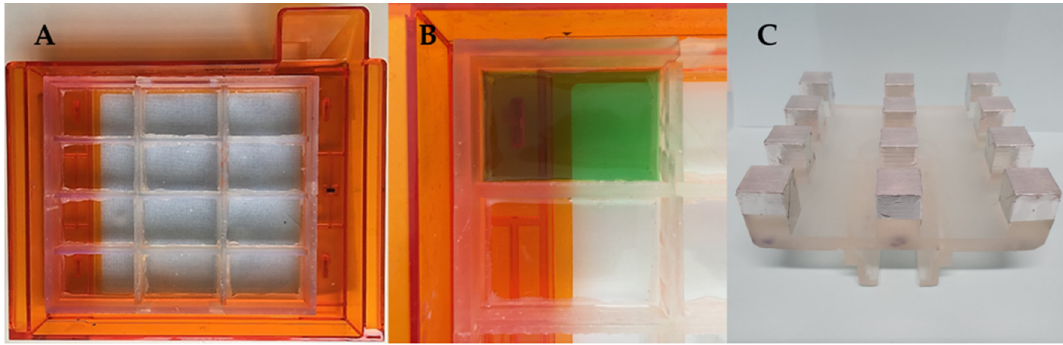
Figure 5. ( A ) Twelve-vats 3D printed insert placed and fixed onto the silicon layer of the original resin tank, ( B ) compart- ments’ sealing test, and ( C ) bottom view of the 3D printed 12 BP showing aluminium tape used to coat each build spot.